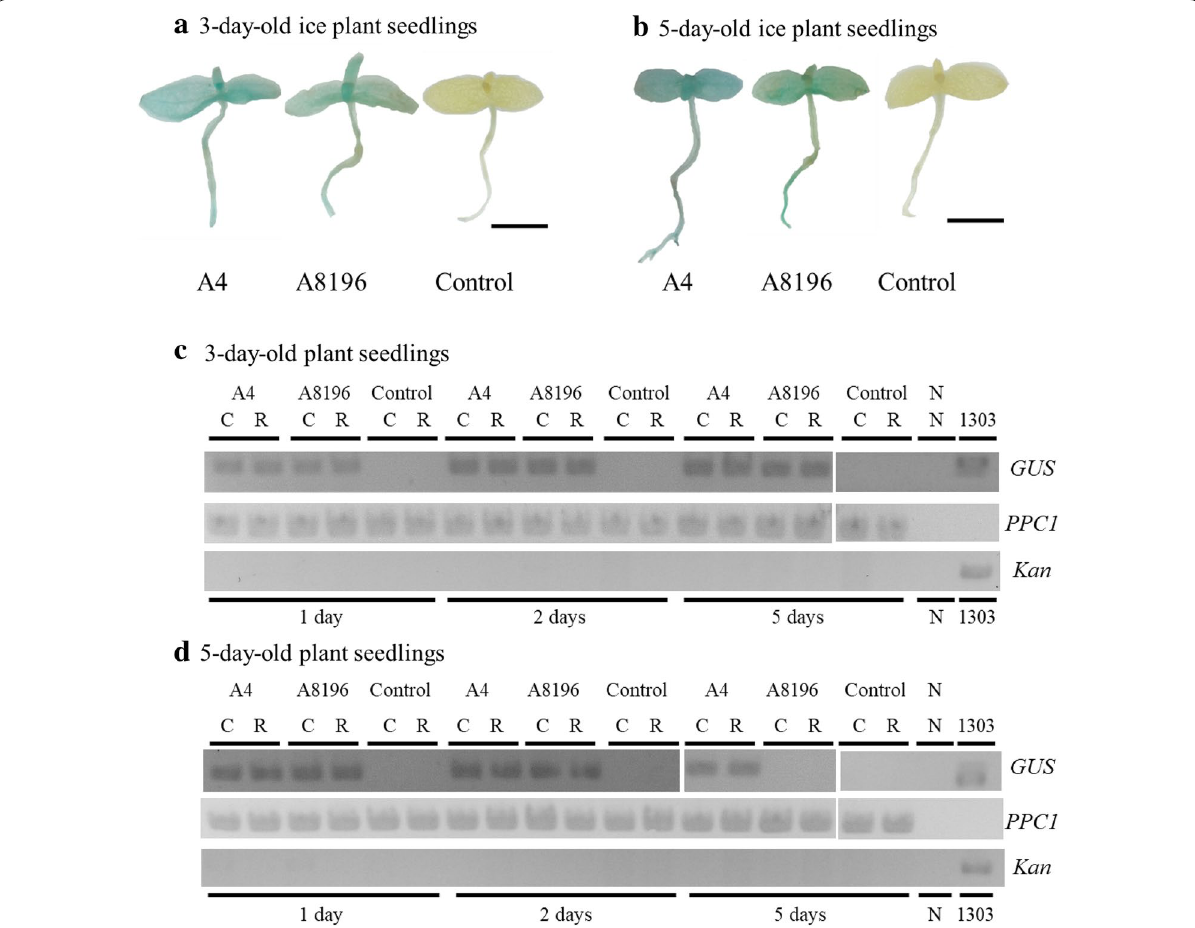
Fig. 3 GUS staining results and genomic DNA PCR results of ice plant seedlings infected with A. rhizogenes A4 or A8196 strain harboring the pCAMBIA1303 binary vector. a , b Representative GUS staining results of 3‑ and 5‑day‑old seedlings infected with A. rhizogenes A4 or A8196 at 2 days after infection and uninfected (control) seedlings. Bar 5 mm. c , d Genomic DNA was isolated from cotyledons (C) and roots (R) of 3‑ and 5‑day‑old = infected and uninfected (control) seedlings. Distilled water was a negative control. The pCAMBIA1303 (1303) plasmid was used as a positive control for the PCR amplifications with the GUS reporter gene and the kanamycin resistance gene ( Kan ). Primers PPC1 3 ′ –5 and PPC1 3 ′ –3 were used to amplify the endogenous PPC1 gene; primers GUS1 and GUS2 were used to amplify GUS reporter gene ( GUS ); primers Kan‑F and Kan‑R were used